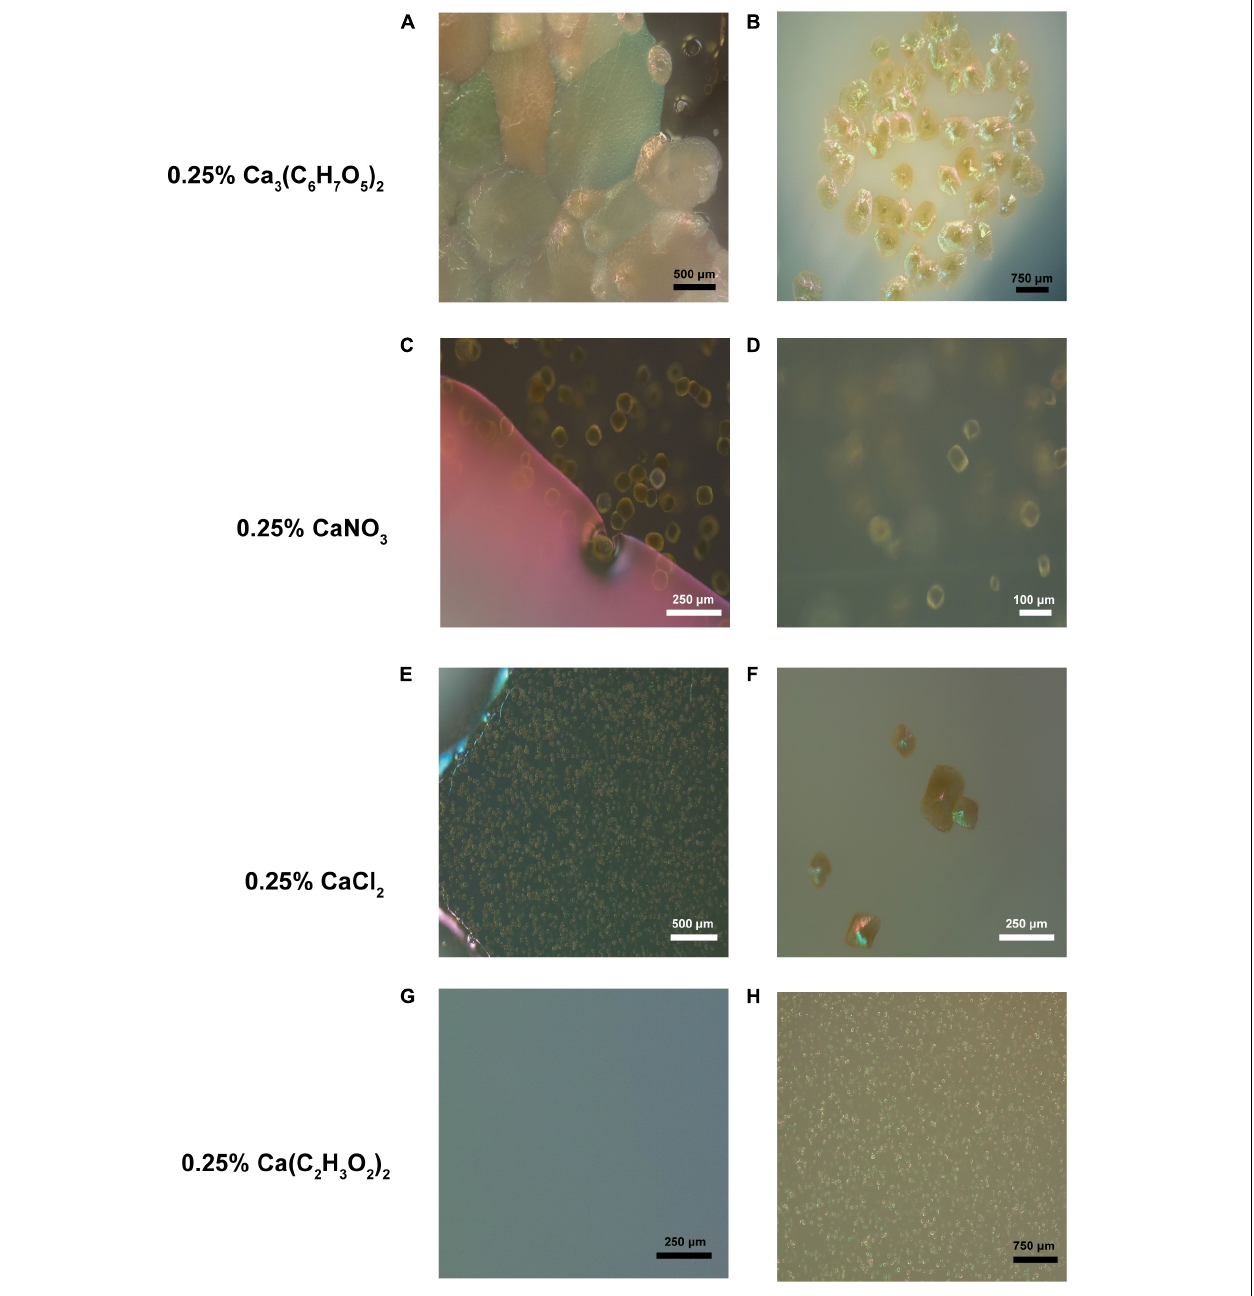
FIGURE 3 | Crystal-like formations observed in various B4 media inoculated with isolates from the soda straw and popcorn speleothems observed by a petrographic microscope. (A) Formations observed adjacent a bacterial colony in the media of a B4 calcium citrate medium plate (131 × ). (B) Formations observed on the surface of a bacterial colony on calcium citrate B4 medium (69 × ). (C) Formations observed adjacent a bacterial colony in the media of a B4 calcium nitrate medium plate (343 × ). (D) Magnified formation on same colony as C (452 × ). (E) Crystals observed in calcium chloride B4 medium (151 × ). (F) Formations observed on calcium chloride B4 medium (306 × ). (G) Uninoculated B4 acetate media plate as a negative control (222 × ). (H) Crystals observed in calcium acetate B4 medium (91 ×